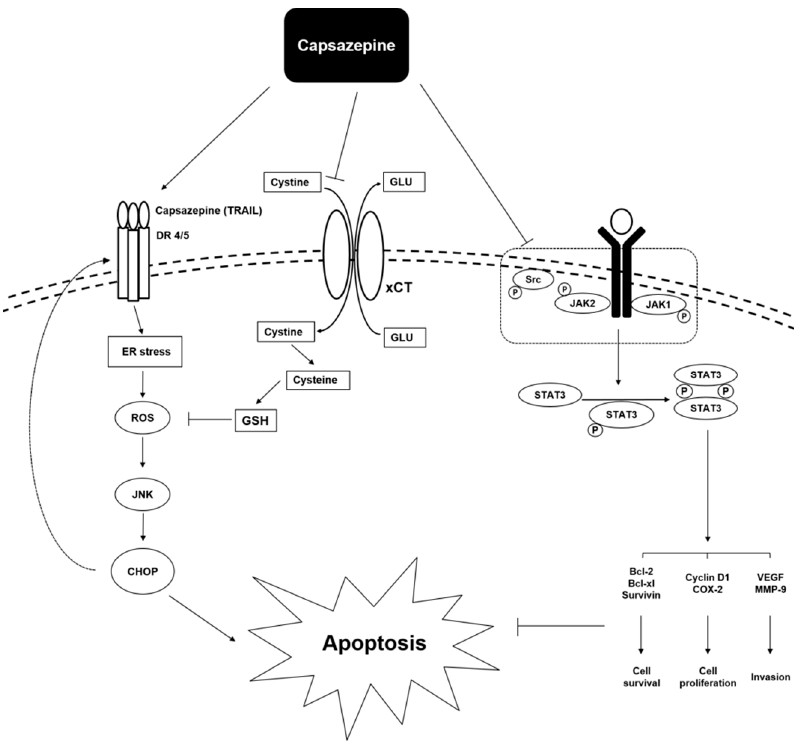
Figure 3. Potential mechanisms underlying reported anti-cancer effects of capsazepine.